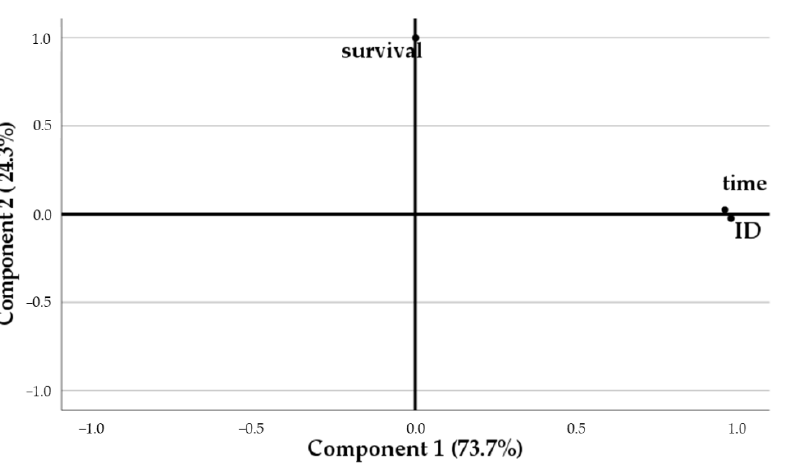
Figure 3. Plot of communalities from component extraction method, pertaining to survival rate throughout gastrointestinal tract.